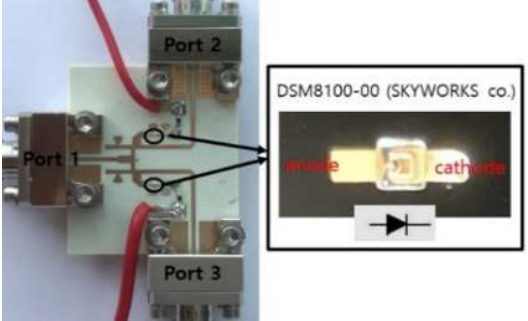
Figure 7. Picture of the fabricated RF switch.